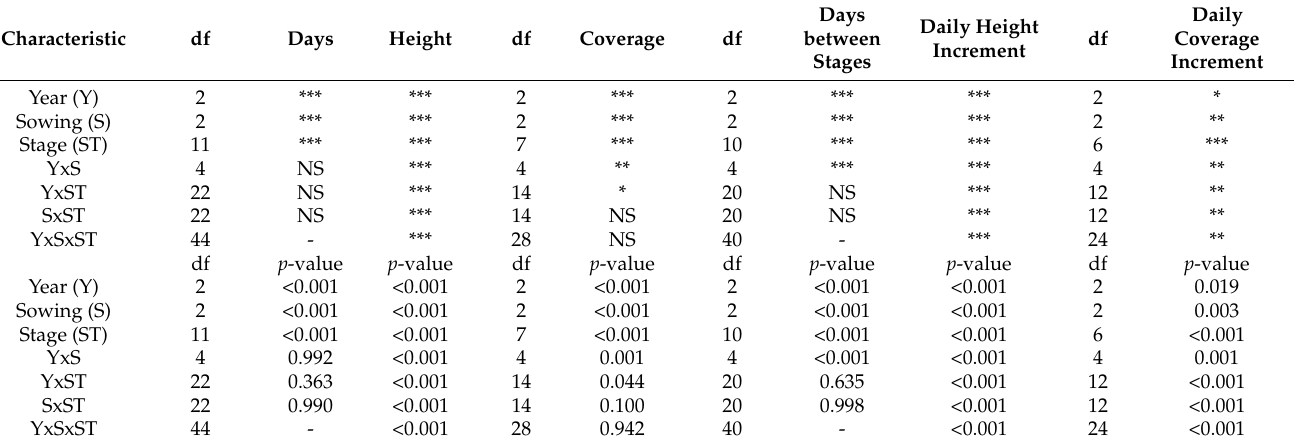
Table 1. Analysis of variance for number of days, plant height, coverage, and daily height and coverage increment.